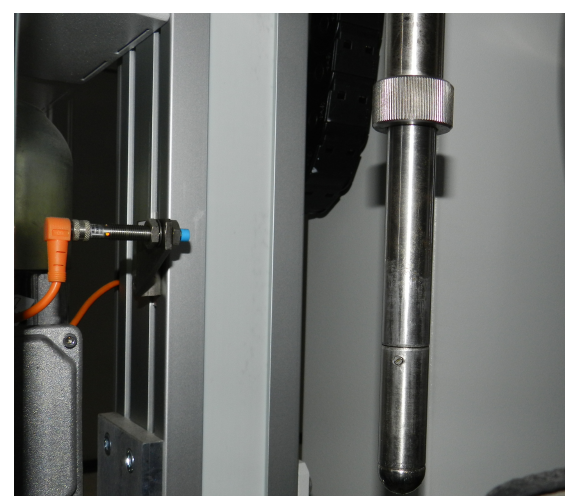
Figure 6. Impactor.